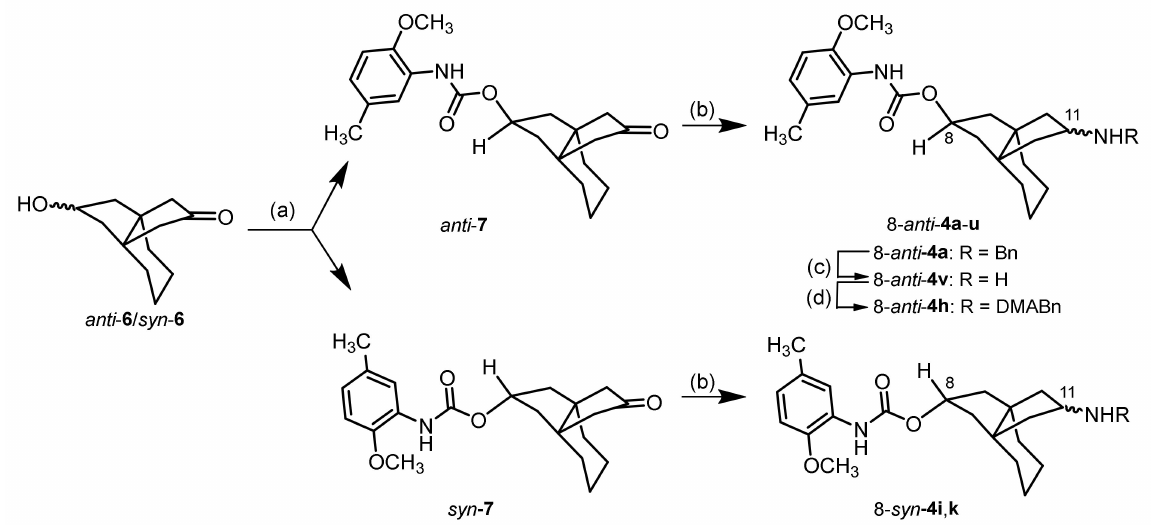
Scheme 1. Synthesis of amino substituted carbamates anti - 4 and syn - 4 . Reagents and reaction conditions: (a) 2-Methoxy- 5-methylphenyl isocyanate, Bu 2 Sn(OAc) 2 , THF, rt, 48 h, 36% ( anti - 7 ), 31% ( syn - 7 ). (b) RNH 2 , NaBH(OAc) 3 , HOAc, ClCH 2 CH 2 Cl, rt, 72 h, 41–93% (exceptions 8- anti - 4s (33%)]. 8- anti - 4t (21%)). (c) NH 4+ HCO 2- , Pd(OH) 2 , CH 3 OH,